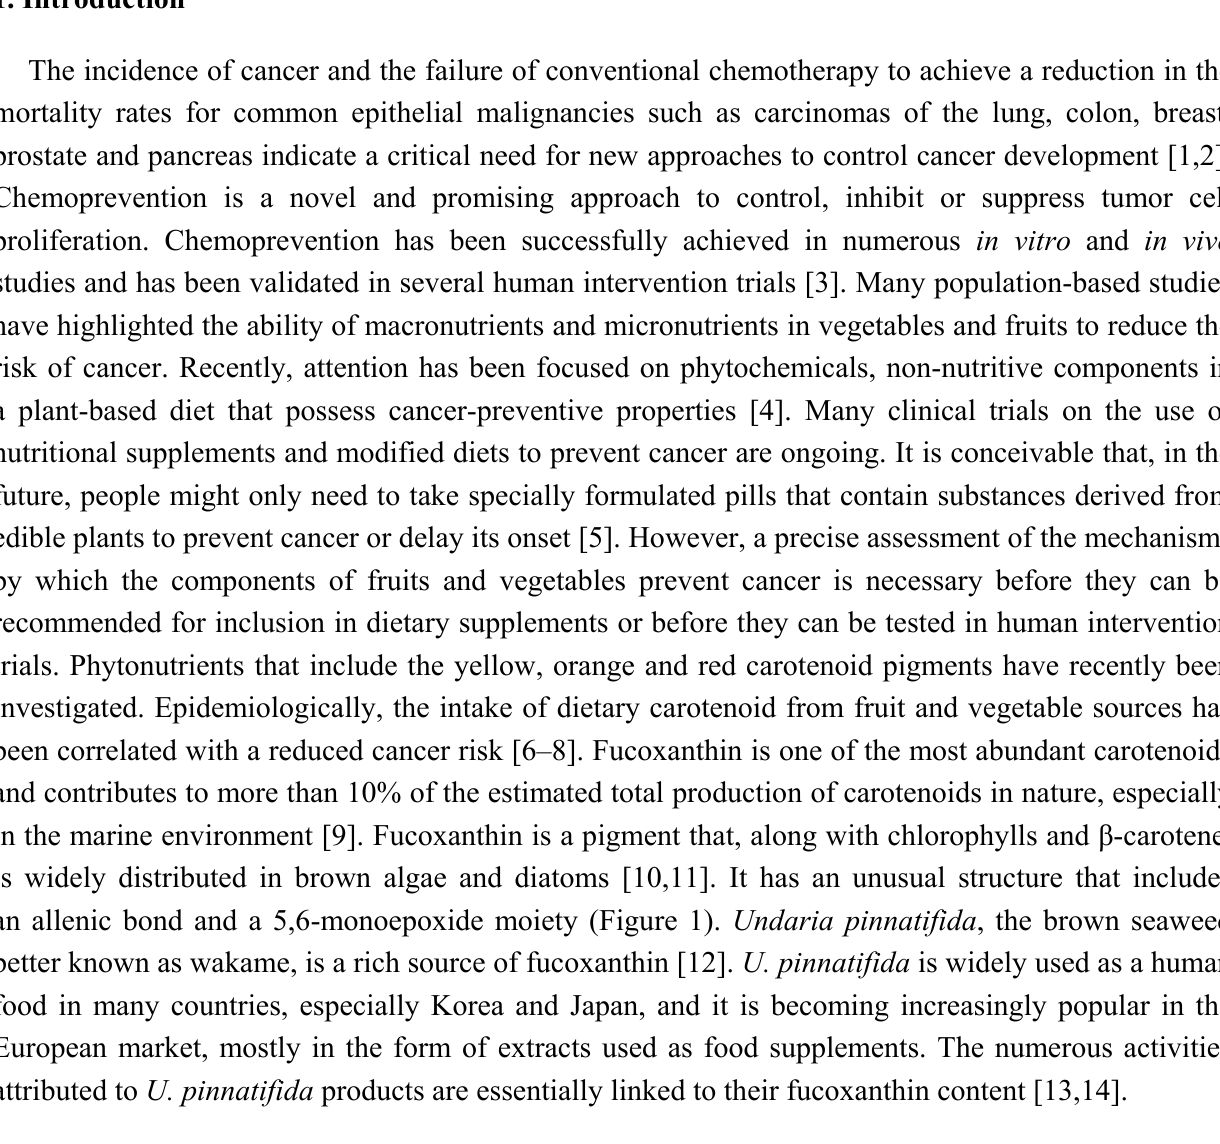
Figure 1. Structure of